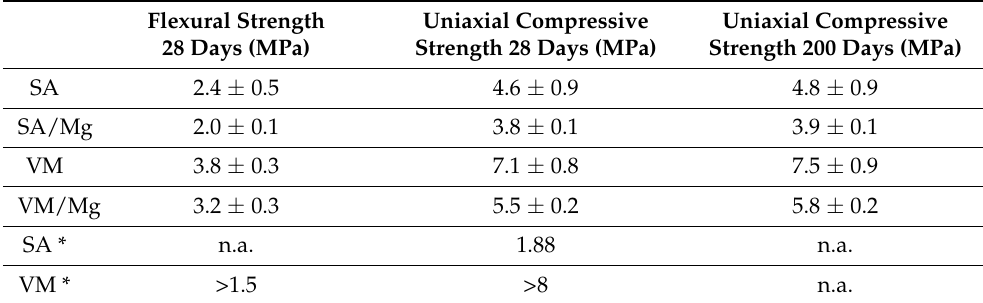
Table 3. Flexural strength and uniaxial compressive strength measured for mortar specimens. * Values given by the producers, n.a. = data not available.